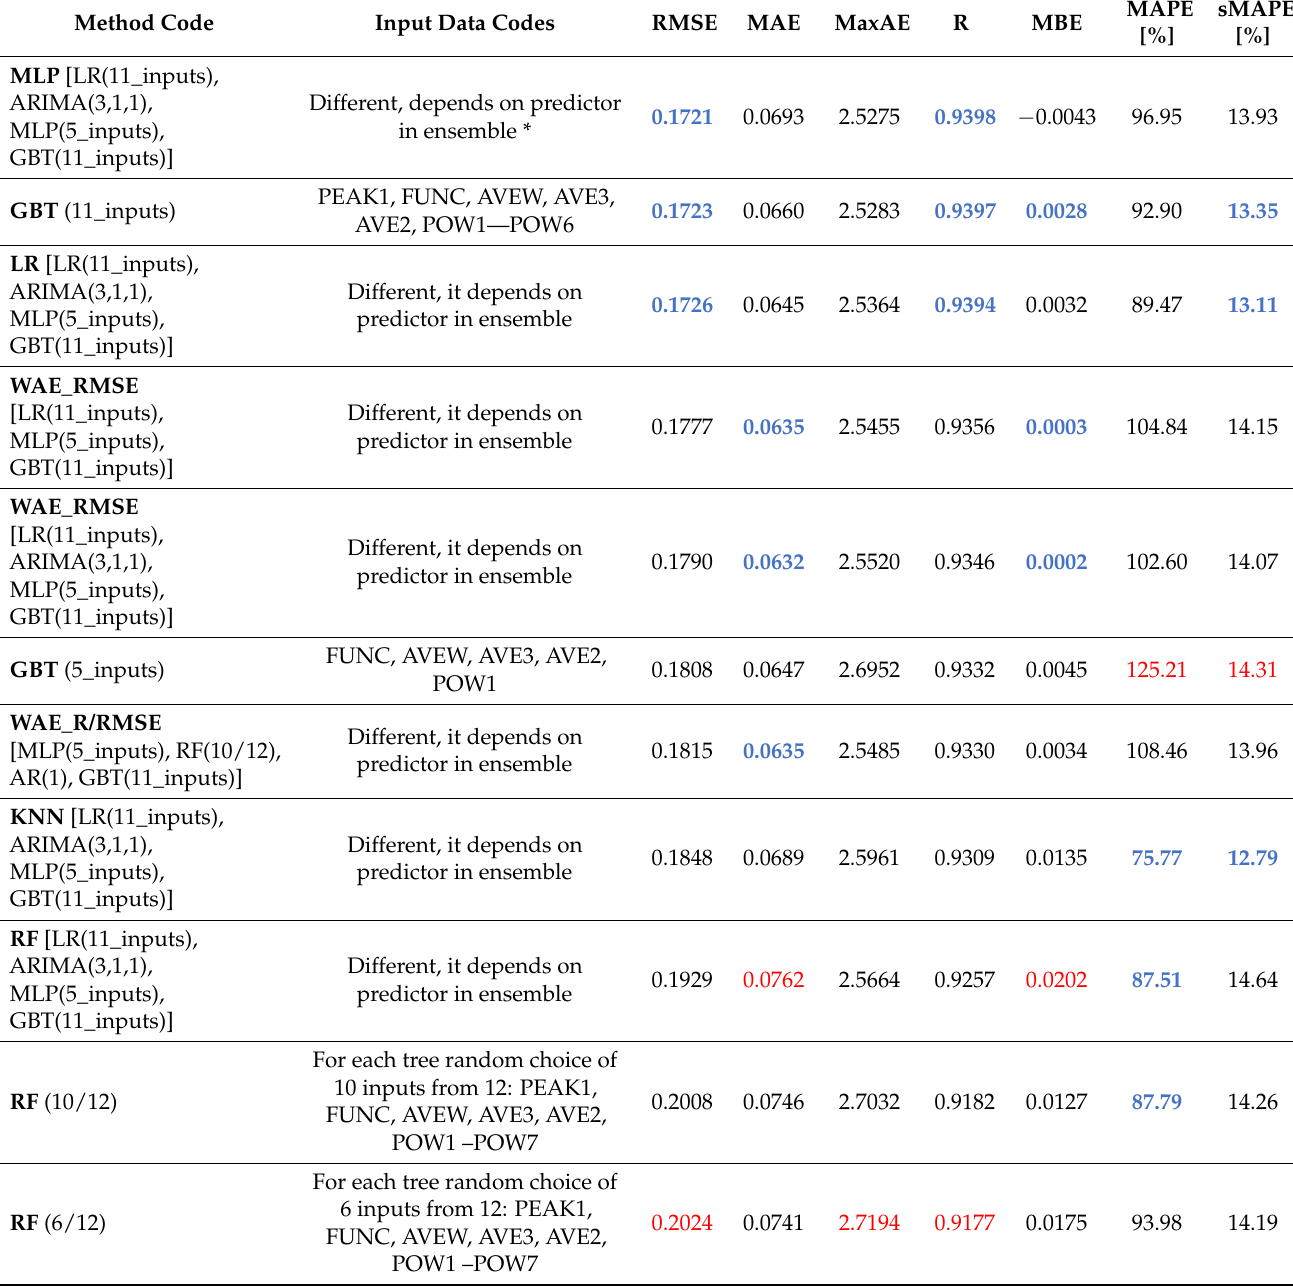
Table 9. Performance measures of proposed ensemble methods (on test subset) for time series No. 2. Method